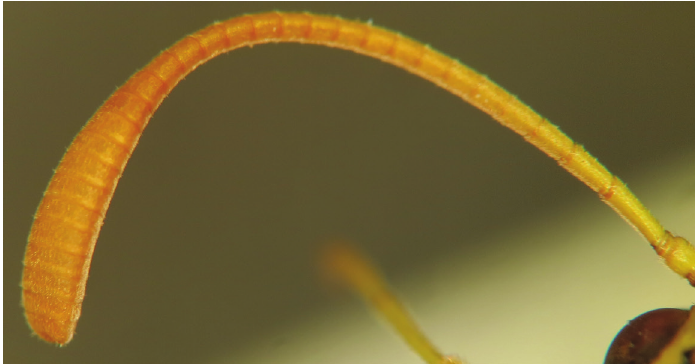
Figure 9. Hellwigia elegans , male antenna (Israel).